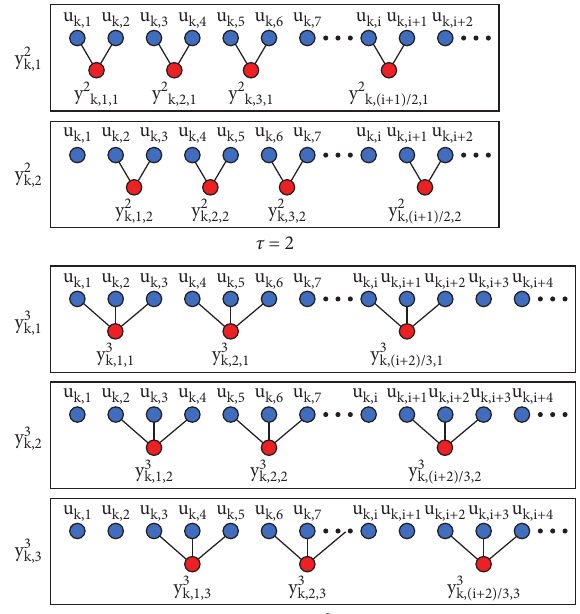
Figure 2: The improved coarse-grained process of multiscale entropy with scale factors τ � 2 and τ �